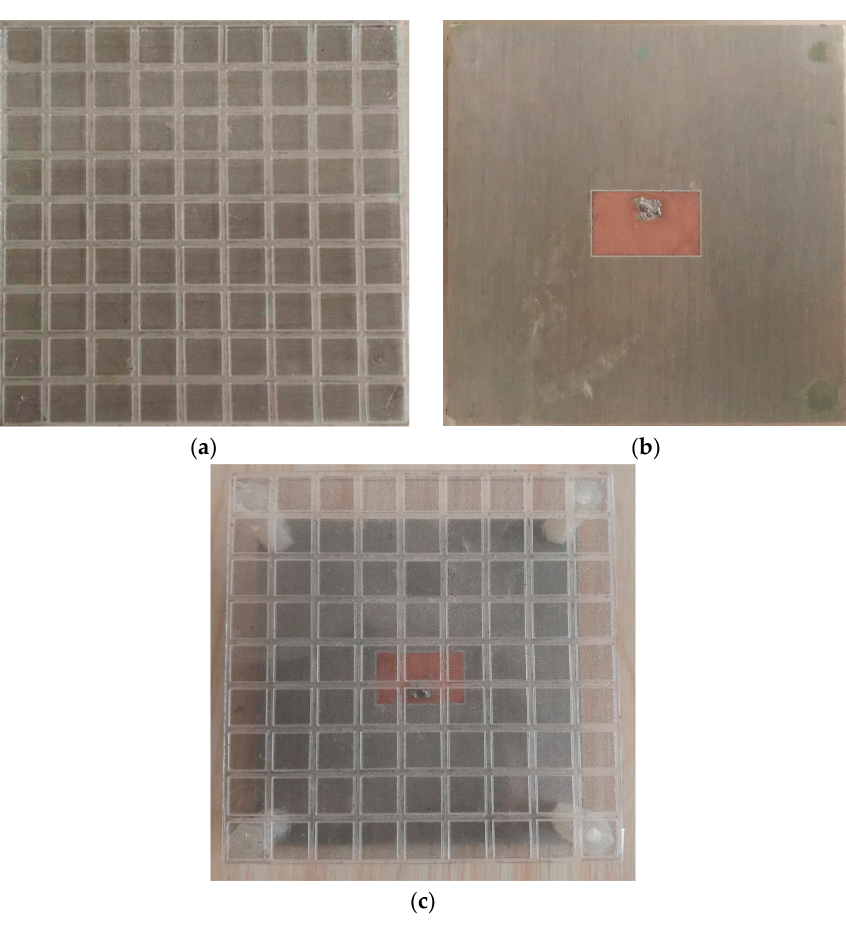
Figure 4. Prototype of ( a ) MS ( b ) patch antenna ( c ) MS antenna. Table 1. Dimensions of the proposed antenna (unit: mm).